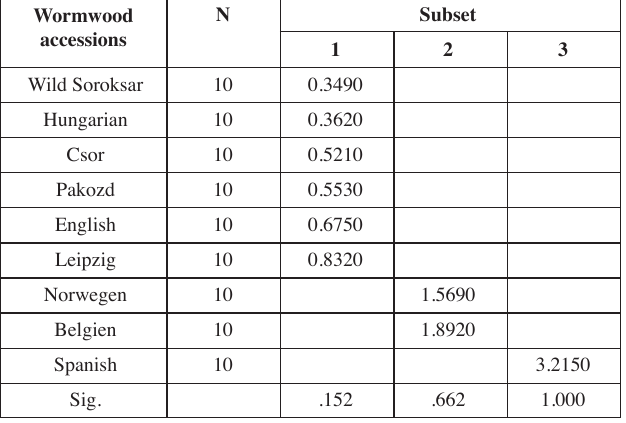
Fig. 1: Herbarium leaf of A.absinthium and devices for leaf measurements 135